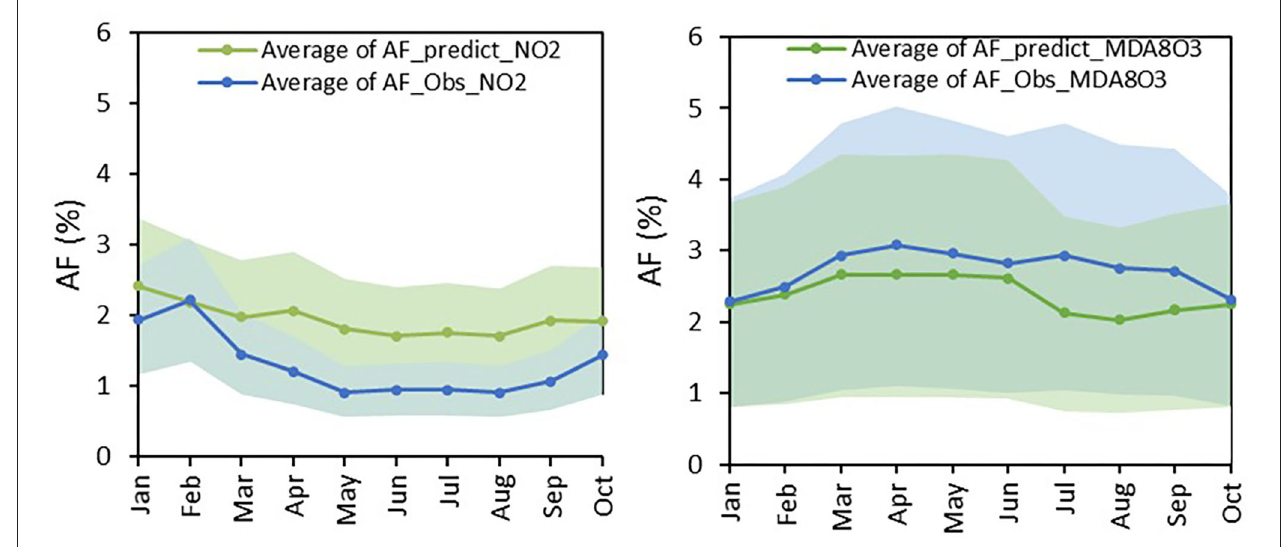
FIGURE 6 | Monthly mean Attributable Fraction (AF; expressed as a percentage of daily all-cause mortality) associated with short-term exposure to (Left) daily mean 1h maximum NO 2 and (Right) MDA8 O 3 concentrations in Msida between January and October 2020 using both measured (blue) and predicted (green) concentrations. Shaded areas represent the 95% confidence interval of the respective CRF